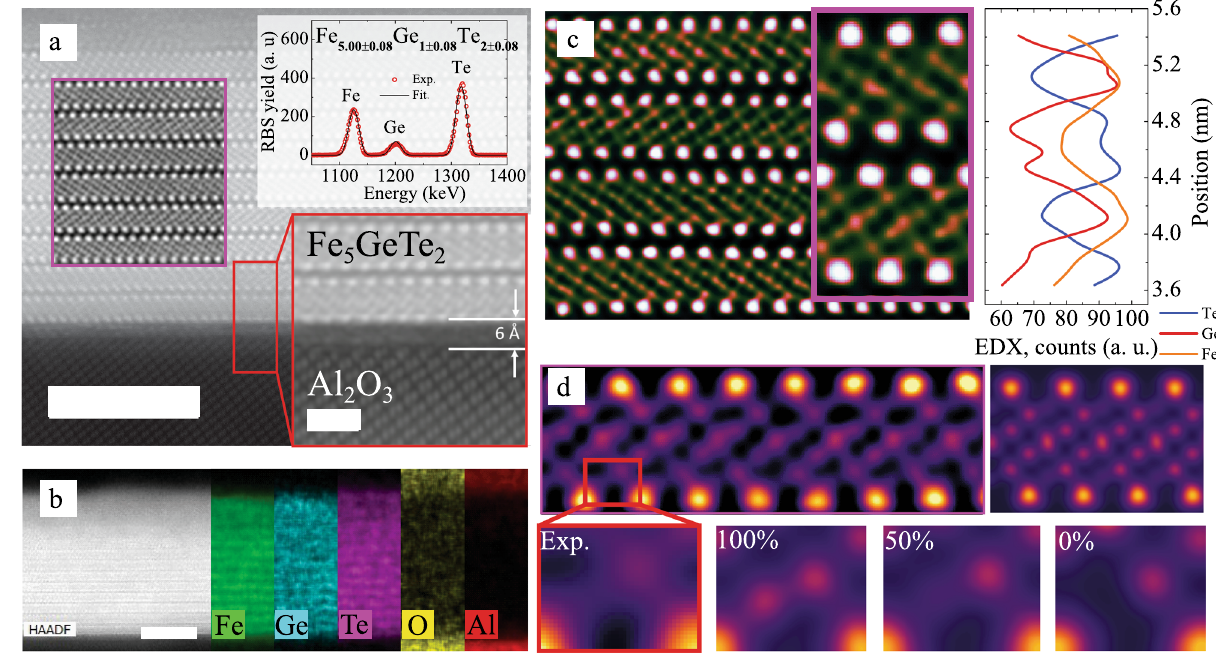
Fig. 3 Transmission electron microscopy of Fe 5 GeTe 2 . a High-angle annular dark- fi eld (HAADF) cross-section image of the 12 nm-thick fi lm along [100]. Left scale bar, 5 nm. Left inset: High-pass fi ltered image of the layers. Top inset: Rutherford backscattering spectroscopy showing stoichiometric 5:1:2 Fe:Ge:Te composition. Bottom inset: Zoomed view of the interface between Al 2 O 3 and Fe 5 GeTe 2 ; scale bar 1 nm. b Element distribution across the layers, determined using energy-dispersive X-ray spectroscopy (EDX); scale bar 5 nm. c Atomic number contrast- enhanced HAADF image of the Fe 5 GeTe 2 layers. The right plot shows an EDX scan over two layers, selective to Te, Ge, and Fe. d Comparison between experimental (top left) and simulated (top right) Z -constrast-enhanced HAADF images. Bottom images are zooms on the Fe1 site. The simulations consider different occupation probabilities of the Fe1